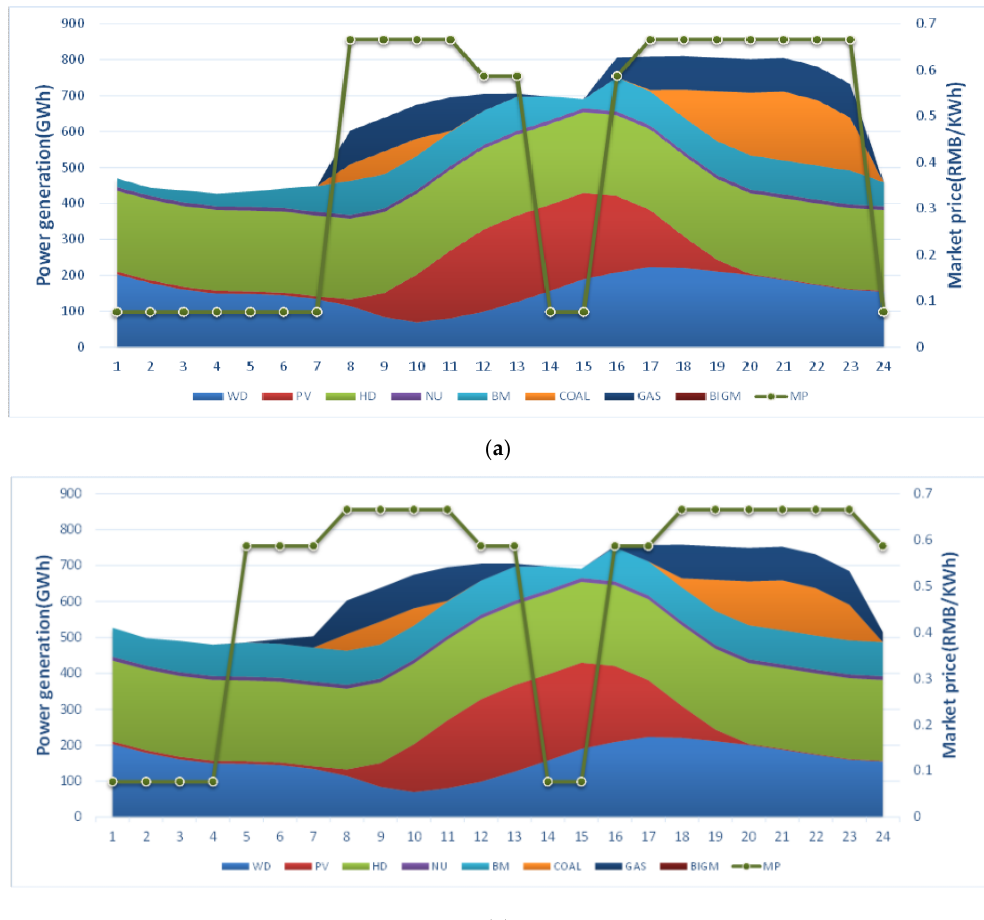
Figure 2. Power generation profiles of China’s electricity market part in a non-typical day during the planning horizon under two demand response scenarios: ( a ) The BAU demand response scenario; and ( b ) the AG demand response